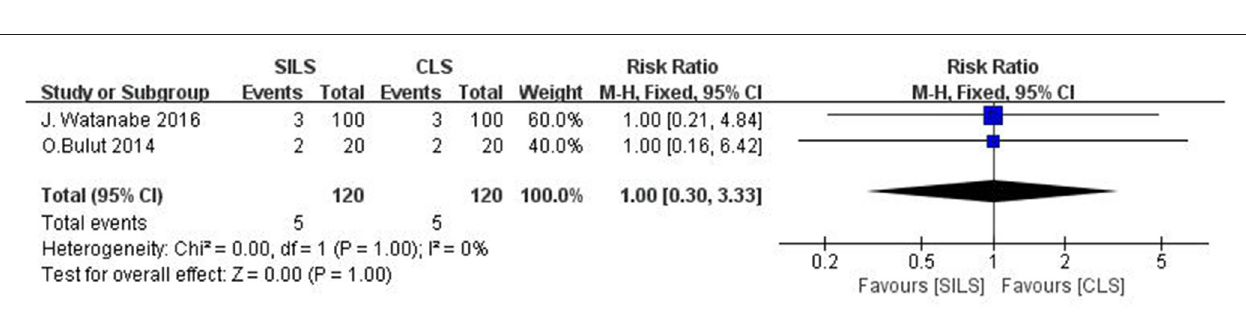
FIGURE 10 | Meta-analysis of reoperation. SILS, single-incision laparoscopic surgery; CLS, conventional laparoscopic surgery.